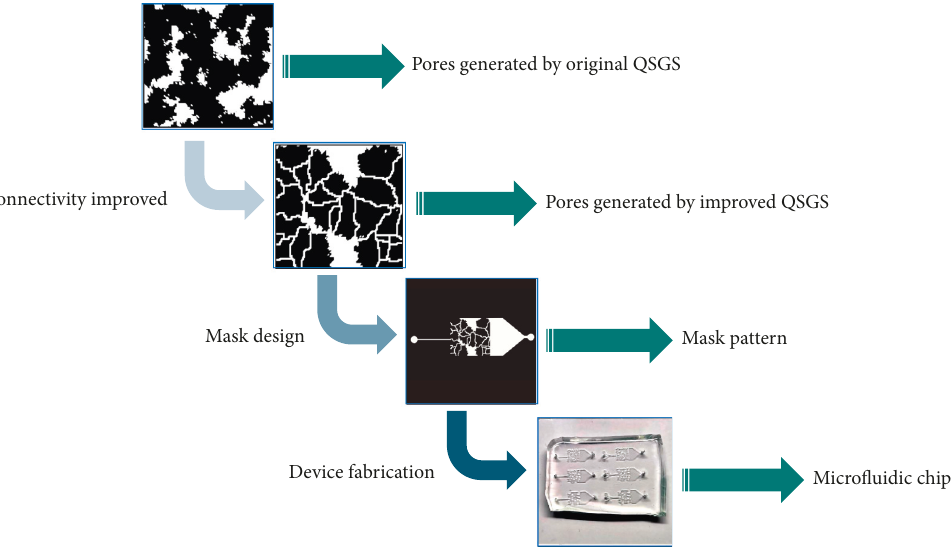
Figure 4: Generated microfluidic chip and mask based on the improved